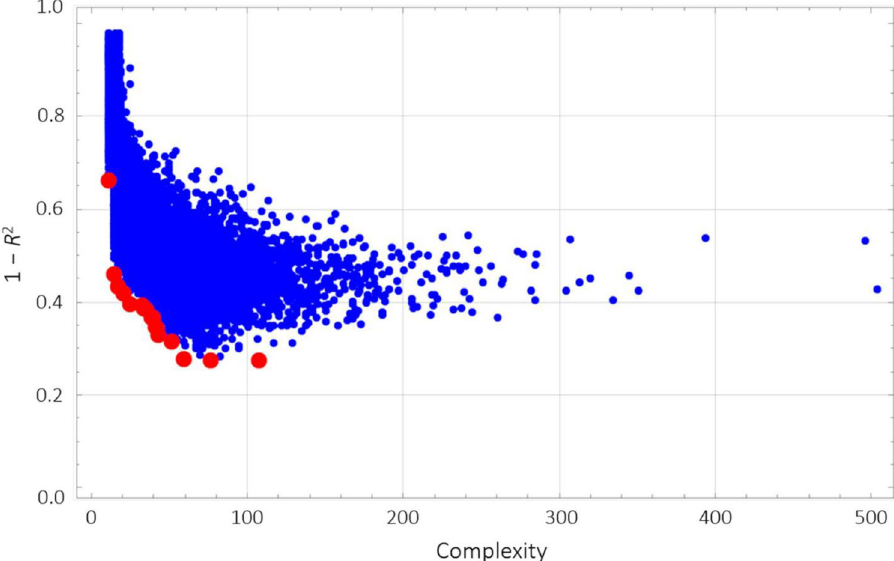
Figure 3. Distribution of functions generated with symbolic regression via genetic programming. Generated functions are plotted on the function space, where the horizontal axis represents the complexity of a function and the vertical axis represents 1 − R 2 or error. In total, 19,437 predictive functions are generated with symbolic regression via genetic programming. Each dot represents one function, and the red dots represent functions on the Pareto front that are candidates for optimized functions with ensemble